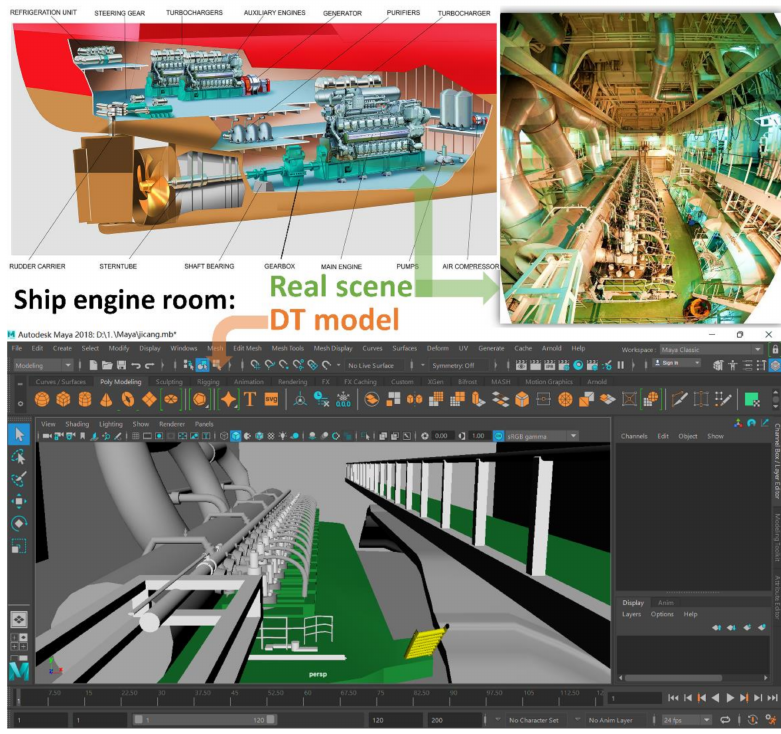
Figure 3. DT modeling for ship engine room.